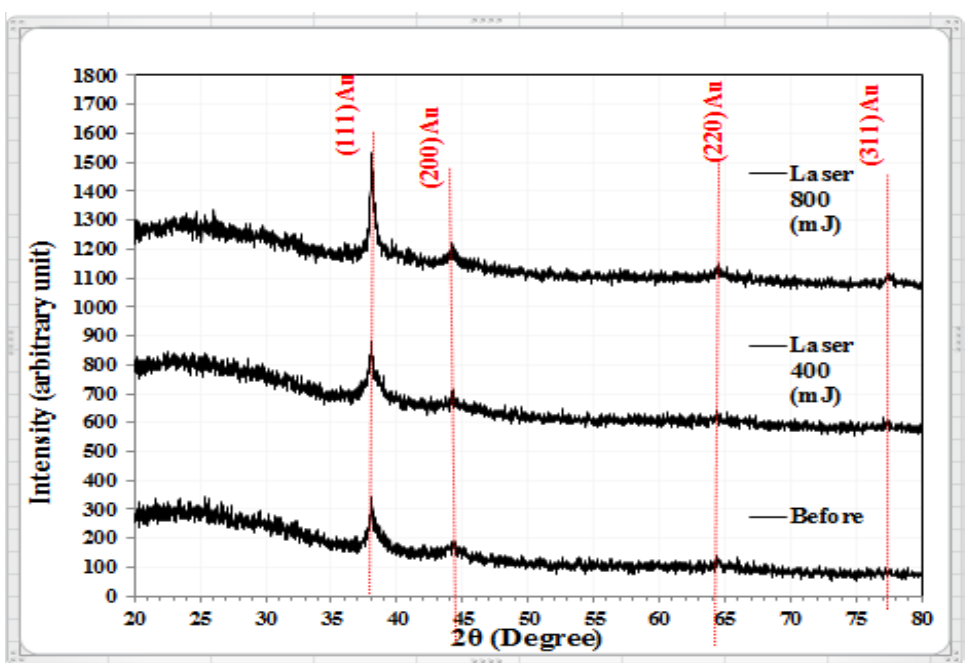
Fig. 11: X-ray diffraction pattern of C-alloy colloid NPs for exploding currents 75A and synthesized by (400 m J, 800 m J) laser energies